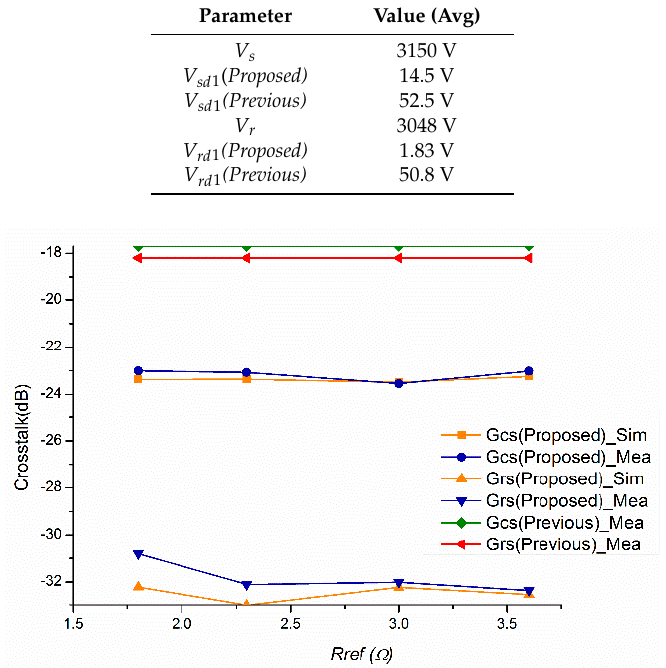
Figure 15. Simulation and measurement of the crosstalk on the transmitter and receiver sides based on the proposed and previous structures for different reflected resistances.